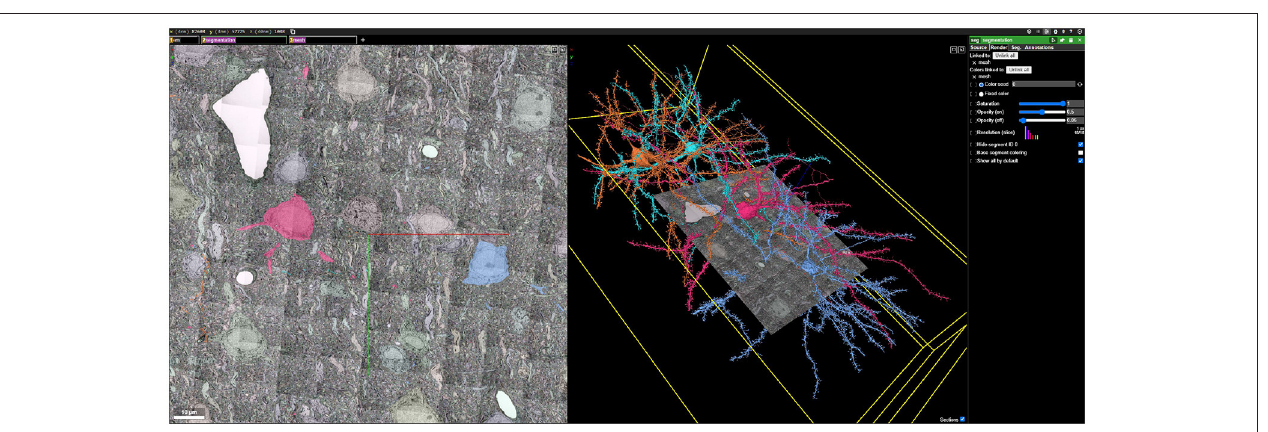
FIGURE 12 | An example Neuroglancer web visualization backended by BossDB , showing public EM, segmentation, and mesh data generated during the IARPA MICrONS Program (see text footnote